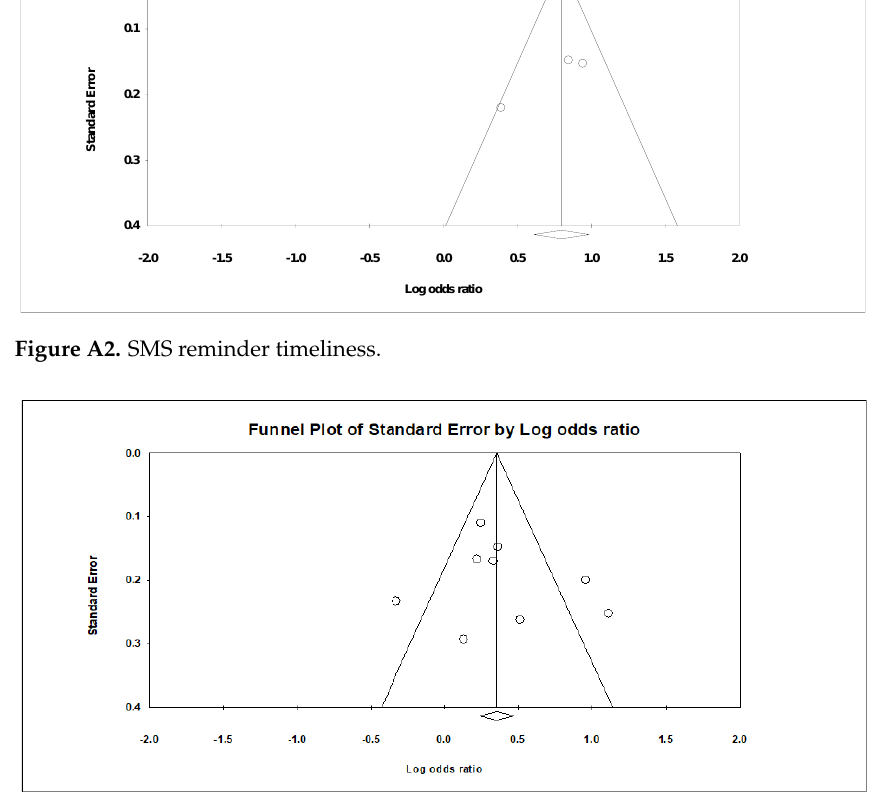
Figure A3. SMS reminder on timeliness